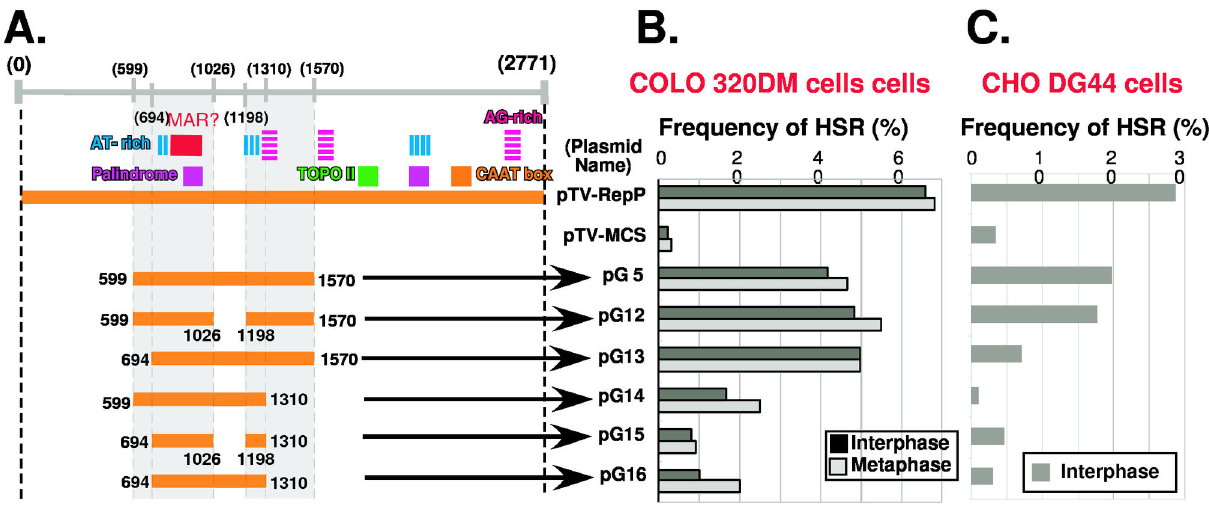
Figure 5. Dissection of ß-globin replicator using a plasmid stability assay. (3) . The G5 fragment, which exhibited the highest HSR-generation activity in Figure 3, was further dissected. The positions of AT-rich, AG-rich, palindrome, topo II binding-site, and CAAT-box regions are indicated. “MAR?” indicates the position of a MAR-like element predicted by the MAR-Wiz program. The regions indicated by orange bars in panel A were subjected to the plasmid-stability assay as in Figure 2. In this case, we examined HSR generation in both COLO 320DM cells and CHO-DG44 cells, in which gene amplification progresses differently, as shown in Figure 1. The results from both cell lines are shown in panels B and C. The data suggest that the gray rectangular regions drawn in the left panel have HSR-generation activity.